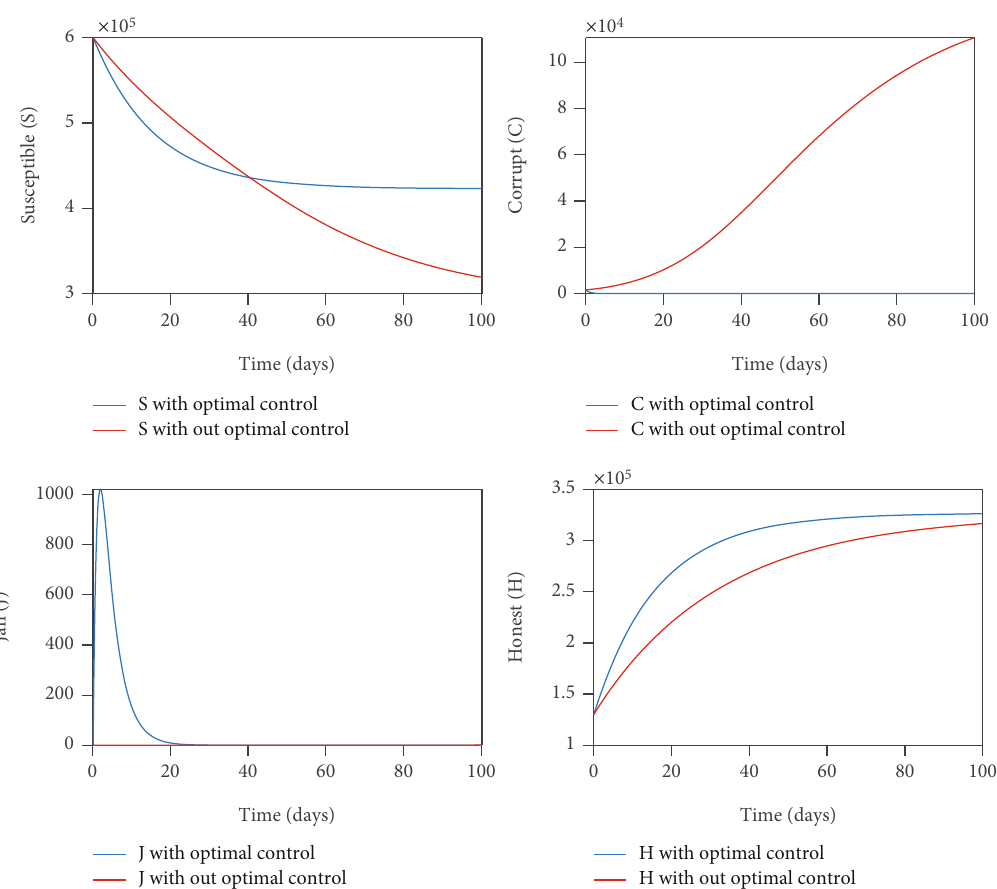
β = 0 : 0234 , δ = 1 and u 2 when